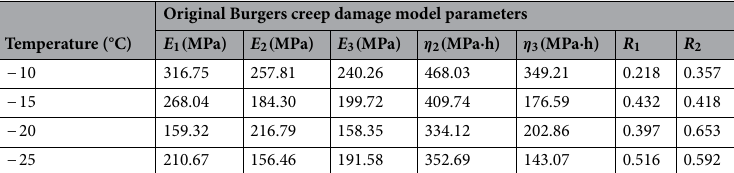
Table 2. Original parameters of the Burgers creep damage model (σ > σ s ).